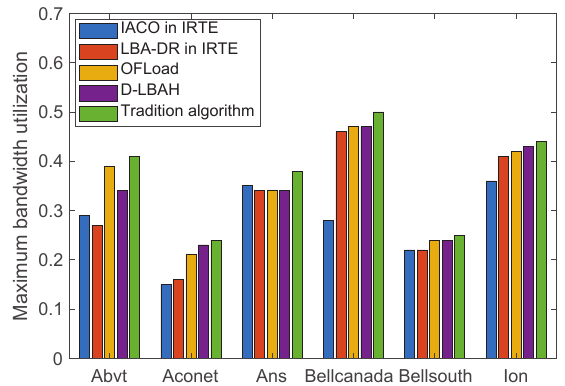
Fig. 3 Maximum bandwidth use in different